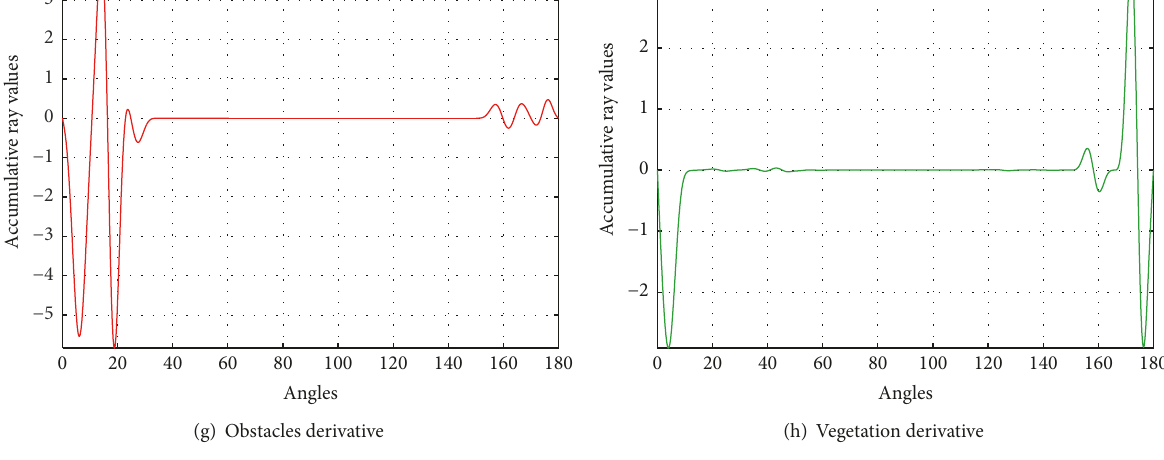
Figure 10: Graph analysis of the rays.